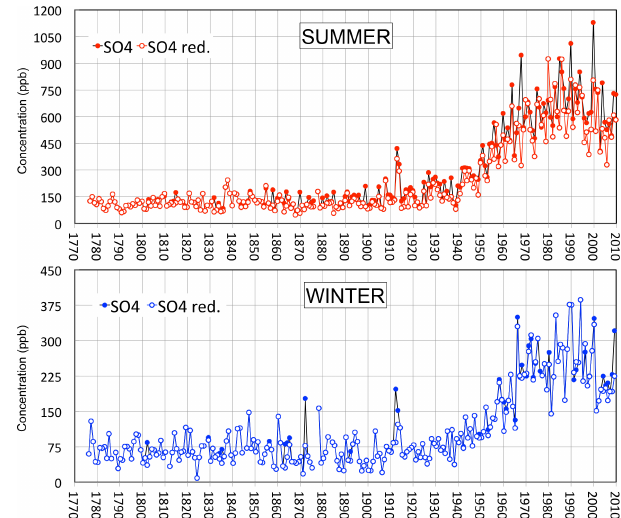
Figure 8. Individual summer (red) and winter (blue) half-year means of sulfate along the ELB ice core. Solid circles refer to values calculated considering all samples. Open circle data (SO 4red . ) were calculated after having removed samples considered to be impacted by large dust events (see Sect.